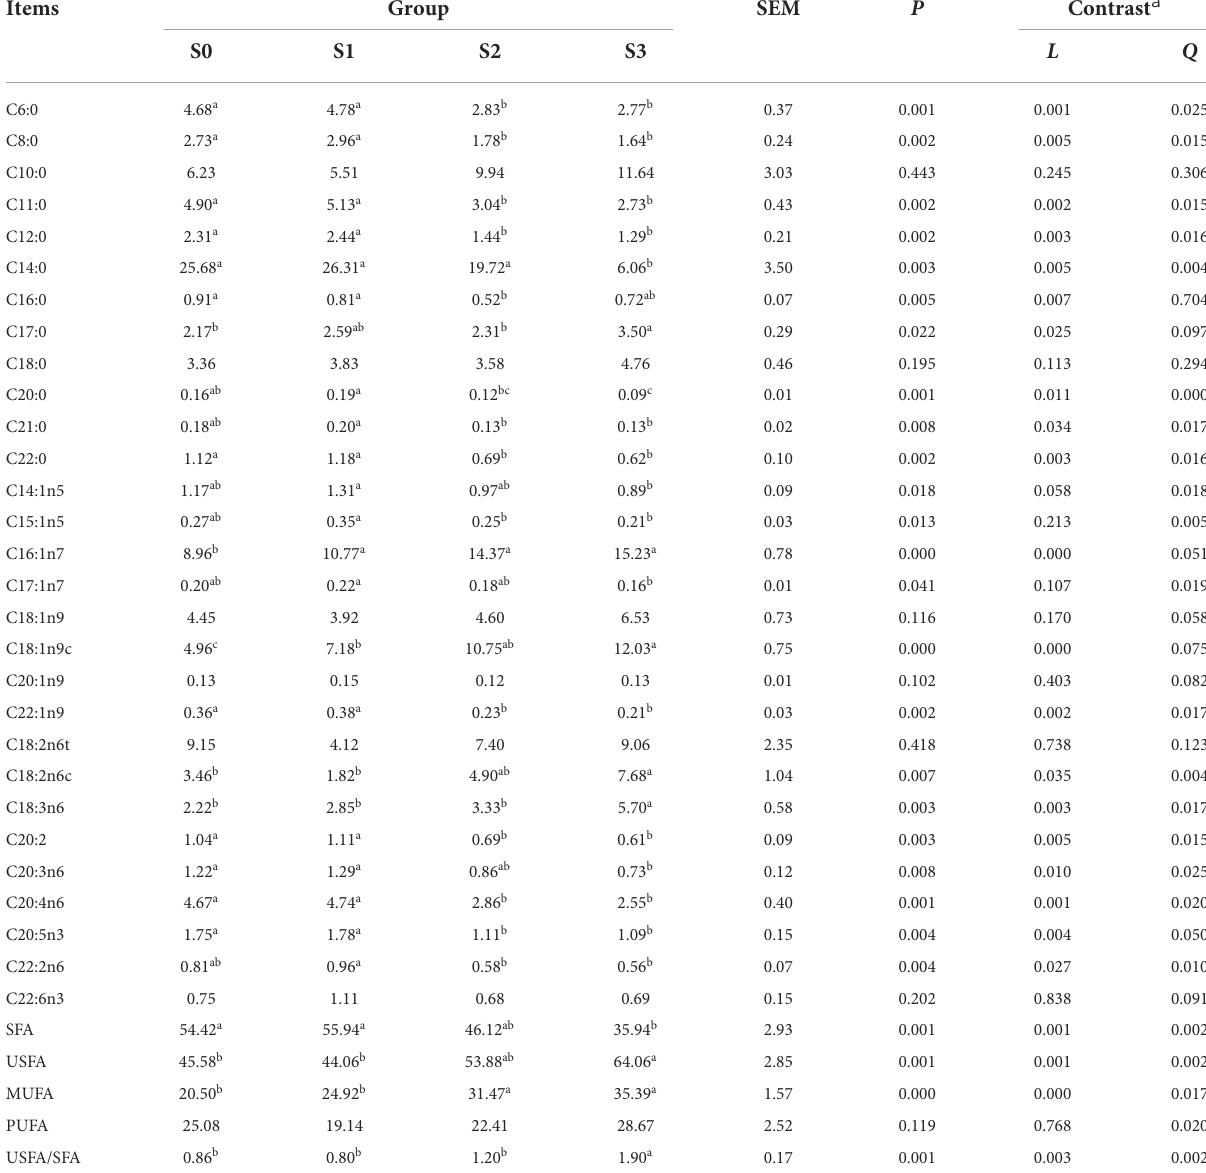
TABLE 6 Fatty acids profile in the breast muscle of broilers